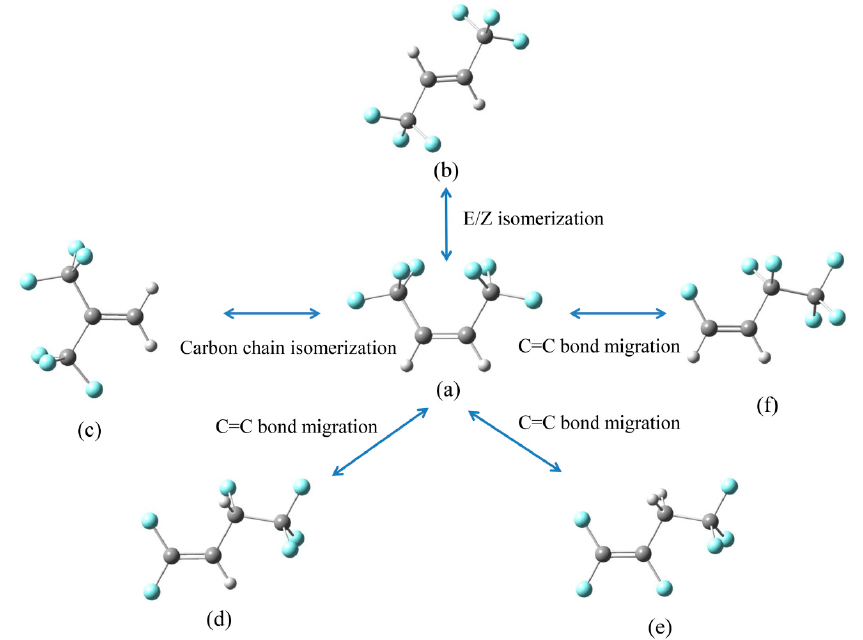
Figure 3. Possible isomerization reaction of HFO-1336mzz(Z). C, H and F atoms are represented with black, gray and blue balls, respectively ( a ): HFO-1336mzz(Z); ( b – f ): Possible isomerization of